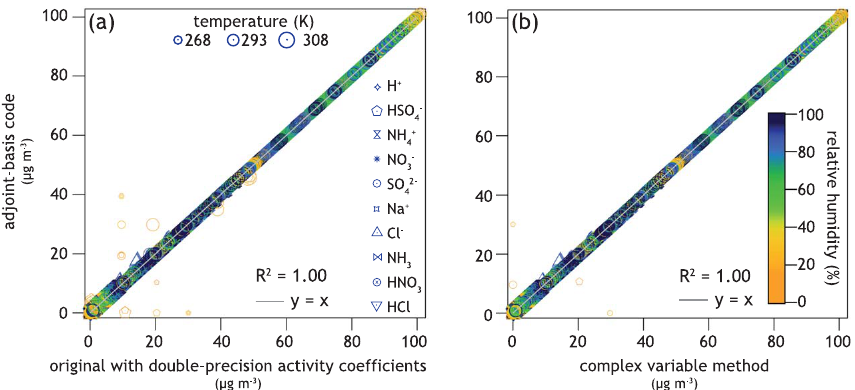
Fig. 2. Evaluation of concentrations of aqueous species in µgm − 3 produced by forward model augmented for adjoint development against (a) ISORROPIA v.2.1 with a modified double-precision activity coefficient module and (b) the complex variable version of ISORROPIA v.2.1 with double-precision activity coefficient module. The atmospherically relevant ranges of concentrations, RH, and temperature evaluated are given in Sect. 3 of the text. In each case, the intercept and slope of the linear regression were negligibly different than 0 and 1,